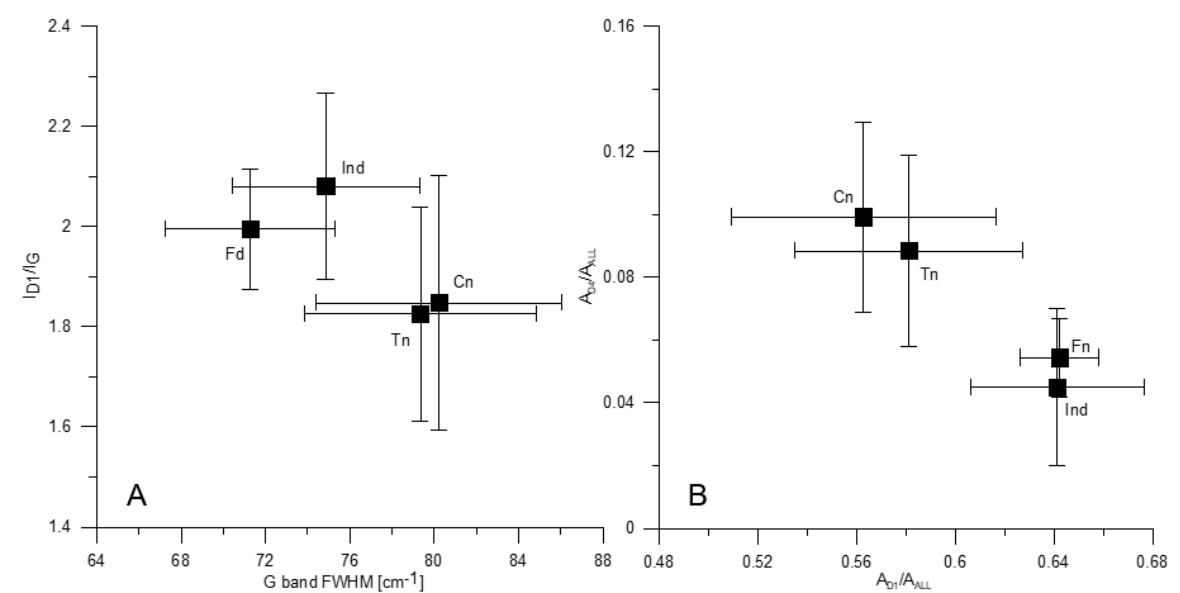
Figure 4. The full width at half maximum (FWHM) of the G band vs. I D1 /I G ratio ( A ) and the A D1 /A ALL vs. A D4 /A ALL ratio ( B ) for the tested morphotypes. Explanations as in Figure 1. The D1 peak is centered at 1340–1344 cm − 1 , and its FWHM ranges from 195 cm − 1 to 208 cm − 1 (Table 6), which means that the size distribution of aromatic clusters does not differ much between the morphotypes studied [77]. In fusinoid, however, it is less varied than in inertoid (lower D1 band half-width), as the Tukey’s HSD test confirms ( p <